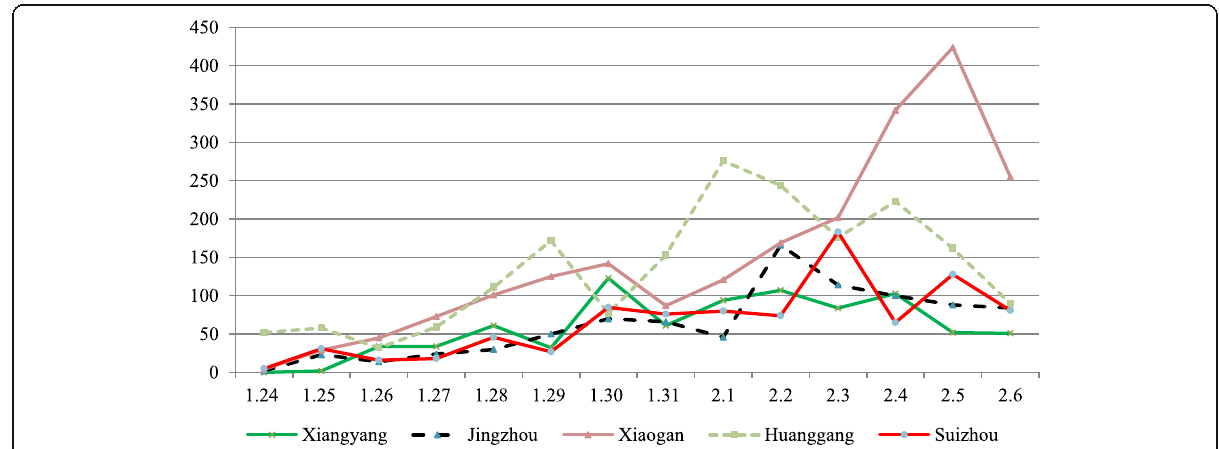
Fig. 3 Daily confirmed cases of COVID-19 in 5 prefecture-level cities in Hubei Province from January 24th to February 6th,